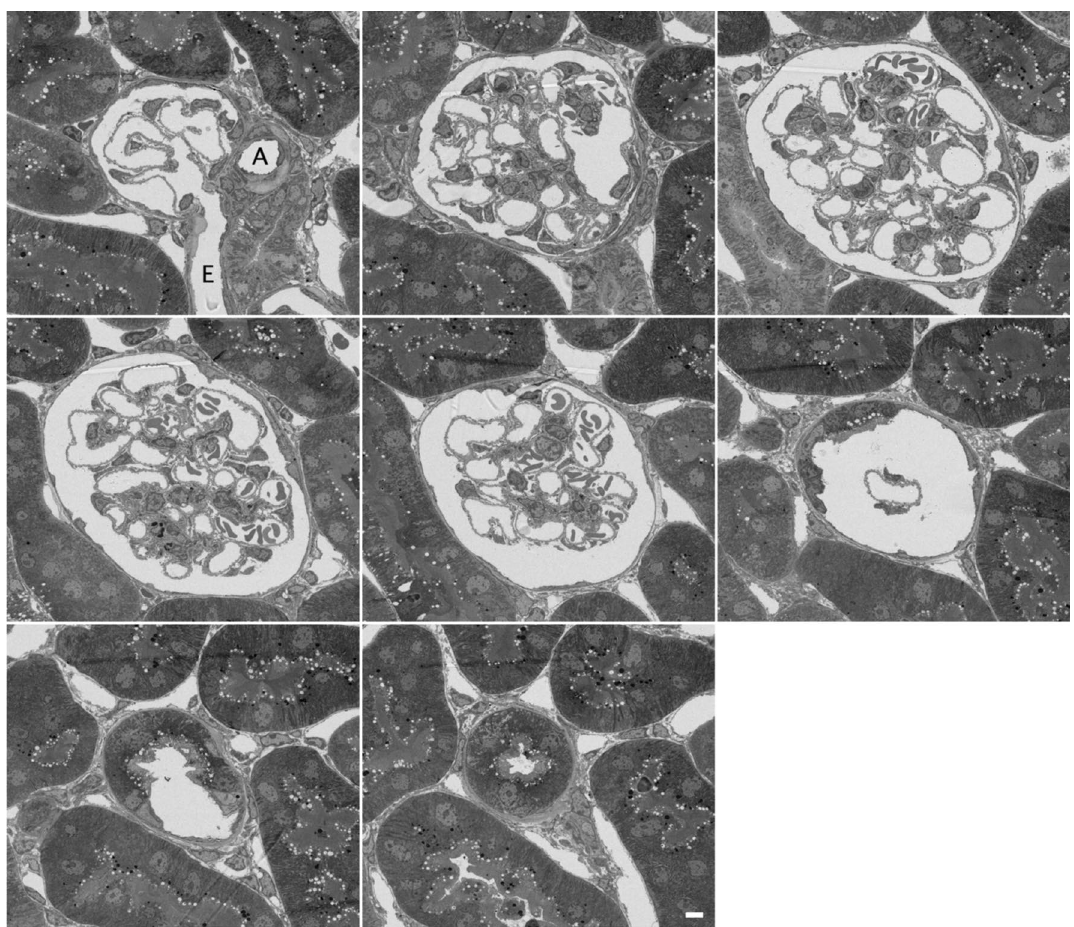
Figure 1. Montage of serial section electron micrographs. The sections were 500 nm thick, and were imaged at 66 nm per pixel. The section numbers were #159, 137, 106, 80, 55, 30, 16 and 6 out of 238 total sections. “A” marks the afferent arteriole, and “E” denotes the efferent arteriole. The urinary pole region is shown in the last two panels. These came from glomerulus #6 of Fig. 2. Scale bar 5